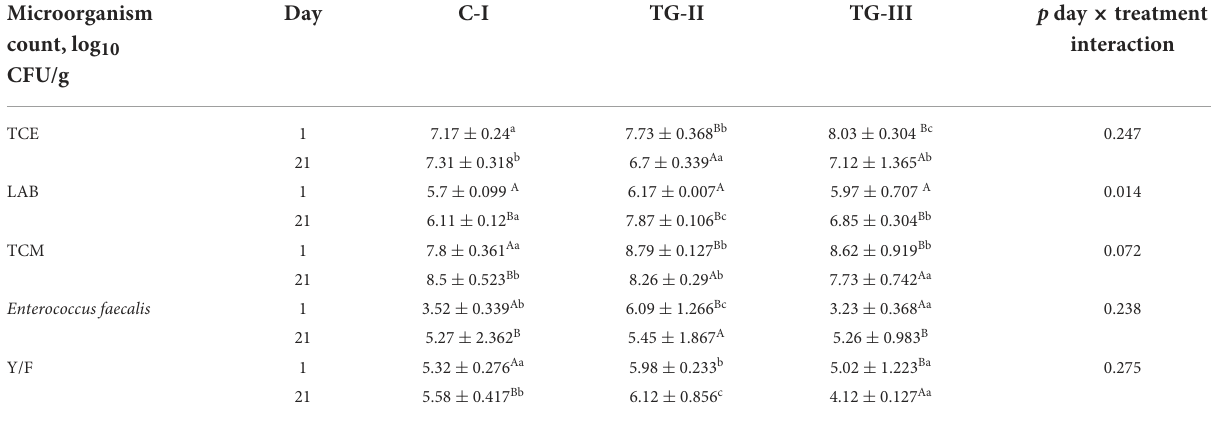
TABLE 4 Microbiological parameters of piglets’ fecal samples.